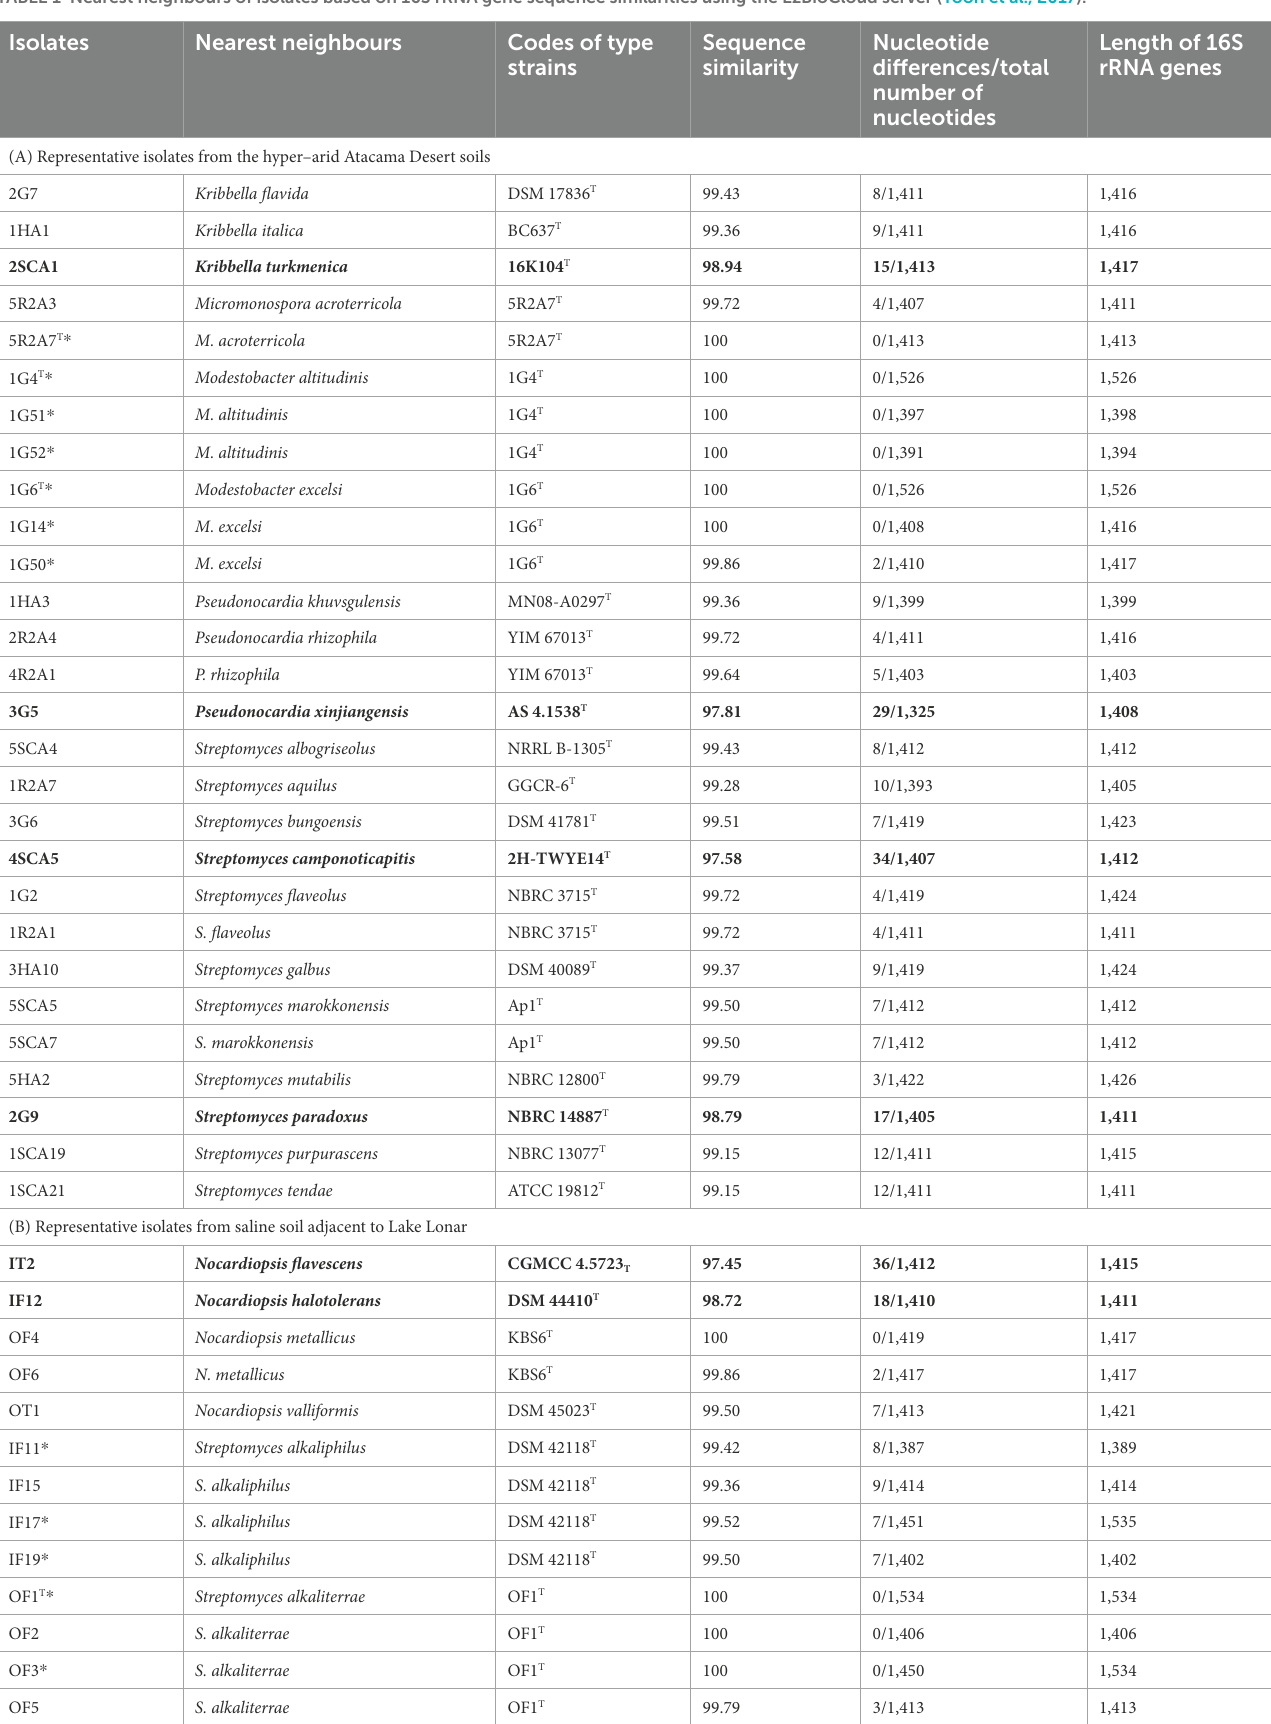
TABLE 1 Nearest neighbours of isolates based on 16S rRNA gene sequence similarities using the EzBioCloud server (Yoon et al., 2017). Isolates Nearest neighbours Codes of type